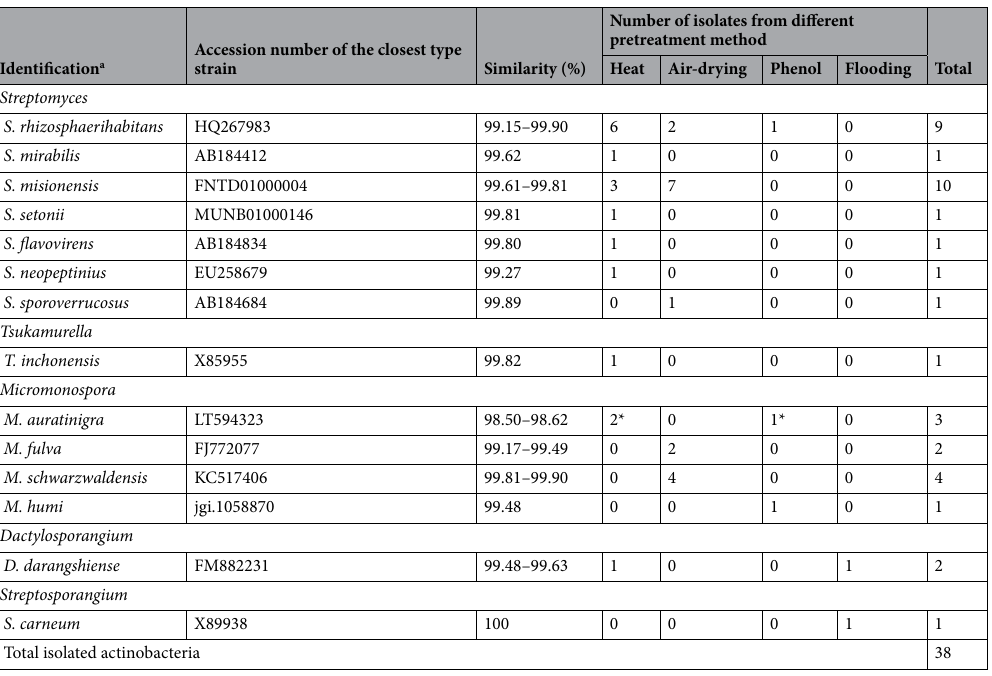
Table 2. Identification of the isolated actinobacteria from Heterodermia lepidota (VP-CM-023) using different pretreatment methods. a nearest match(es). *considered as novel species.